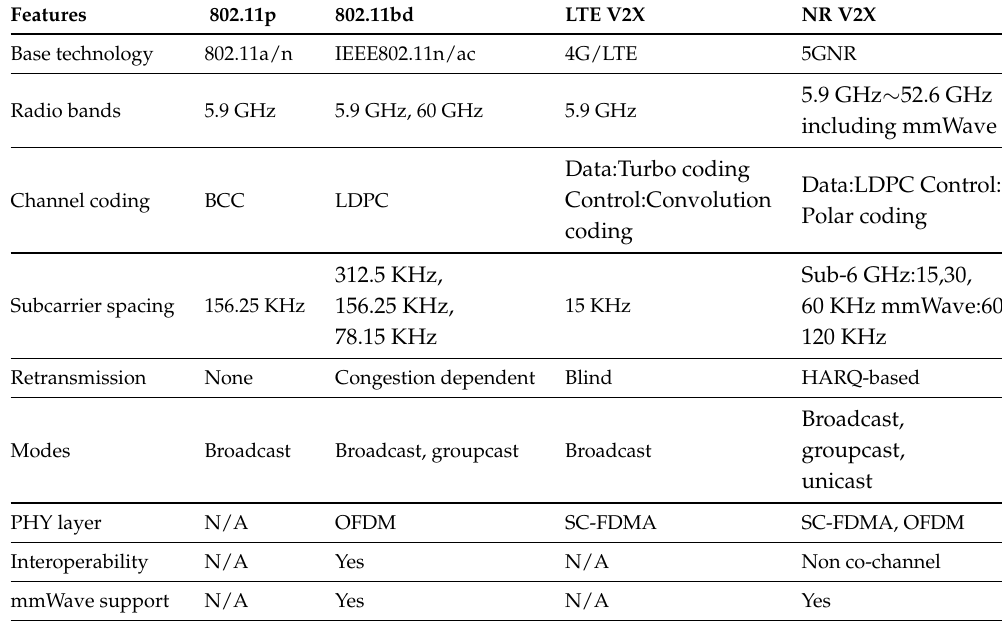
Table 5. An overall comparison of 802.11p, 802.11bd, LTE V2X, and NR V2X based on common